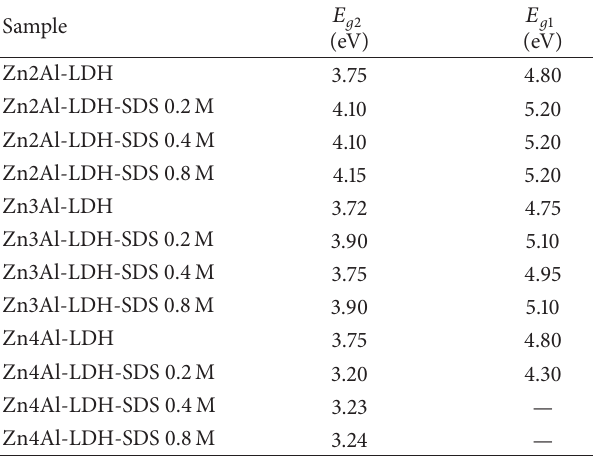
Table 2: The energy gaps of Zn r Al–NO different concentrations of SDS.